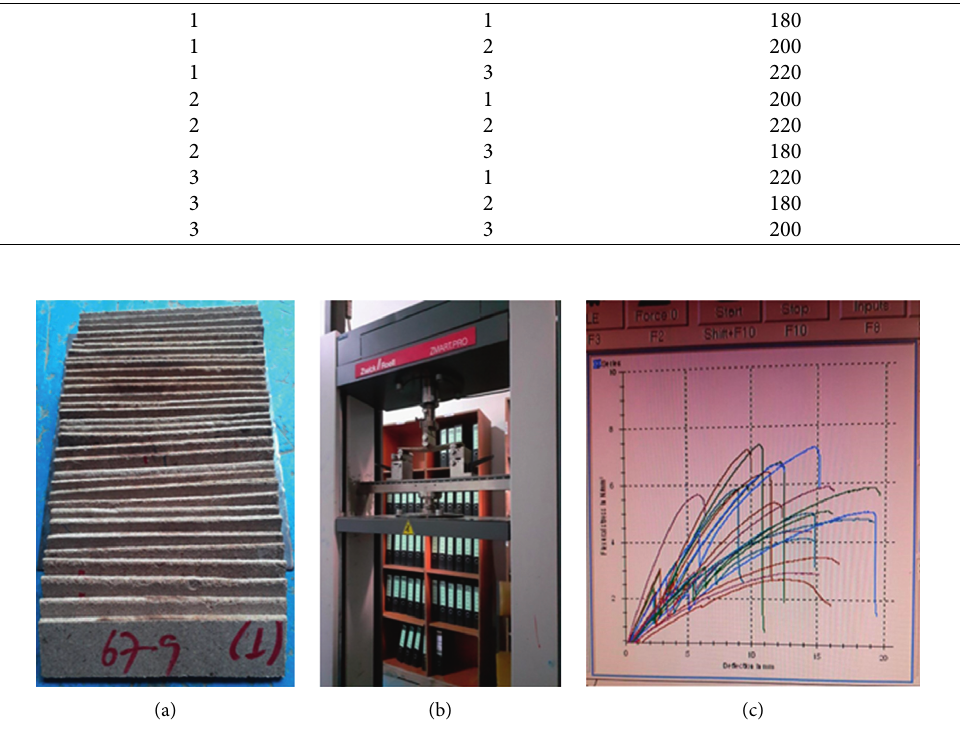
Figure 2: Test procedure and graph for flexural strength.